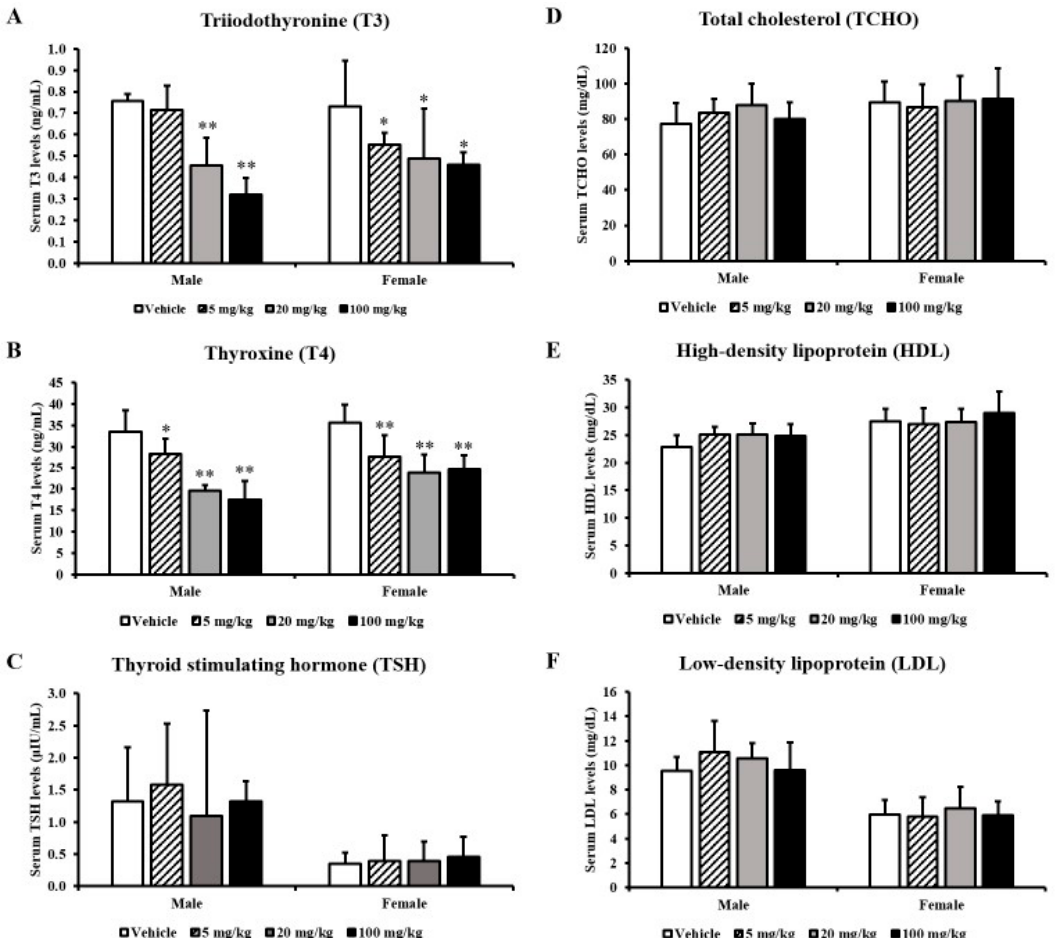
Figure 2. Serum concentrations of thyroid hormones and hormone-related parameters in rats treated with F-53B. The levels of triiodothyronine (T3) ( A ), thyroxine (T4) ( B ), thyroid-stimulating hormone (TSH) ( C ), total cholesterol (TCHO) ( D ), high-density lipoprotein (HDL) ( E ), and low-density lipoprotein (LDL) ( F ) in rat serum after F-53B treatment. The data are displayed as the mean ± s.d. ( n = 7). For values that differ significantly as assessed by one-way analysis of variance and Dunnett’s test: * indicates p < 0.05 compared with the vehicle control group and ** indicates p < 0.01 compared with the vehicle control group. Table 1. Incidences of thyroid gland follicular hyperplasia in the 28-day toxicity study of F-53B.